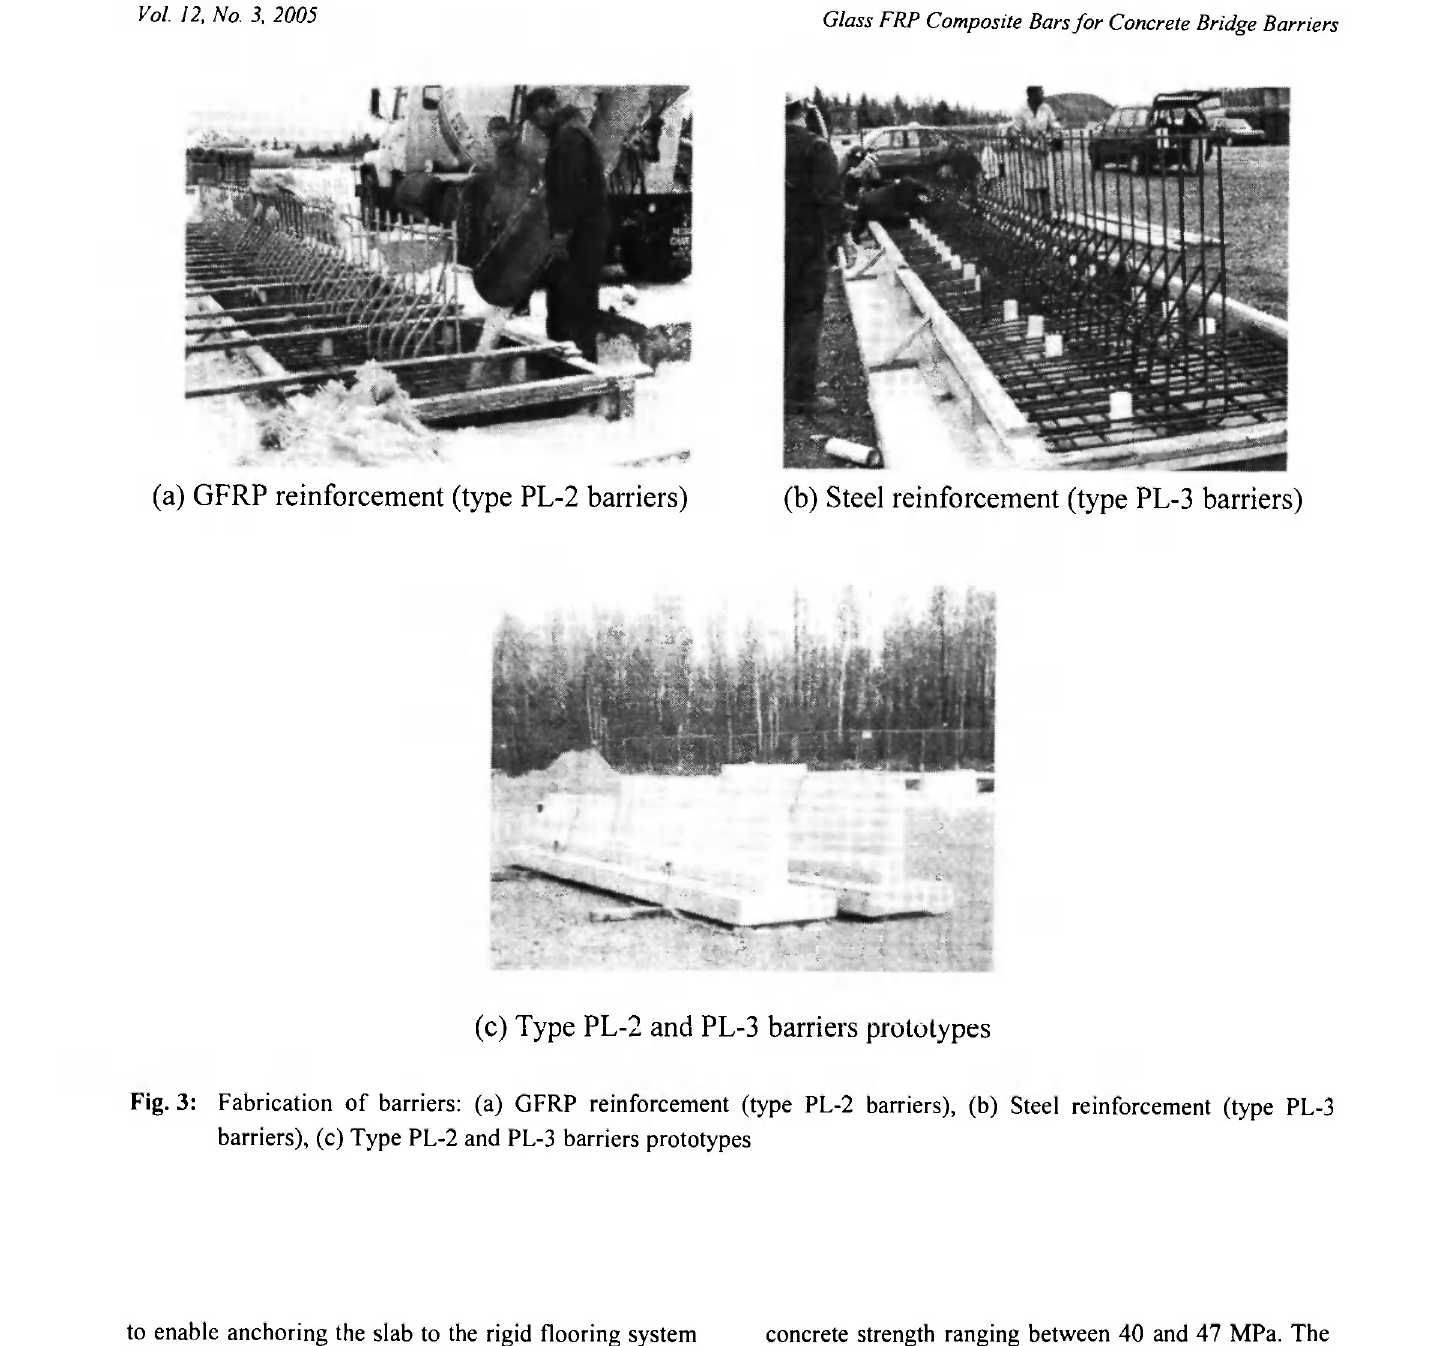
Fig. 3: Fabrication of barriers: (a) GFRP reinforcement (type PL-2 barriers), (b) Steel reinforcement (type PL-3 barriers), (c) Type PL-2 and PL-3 barriers